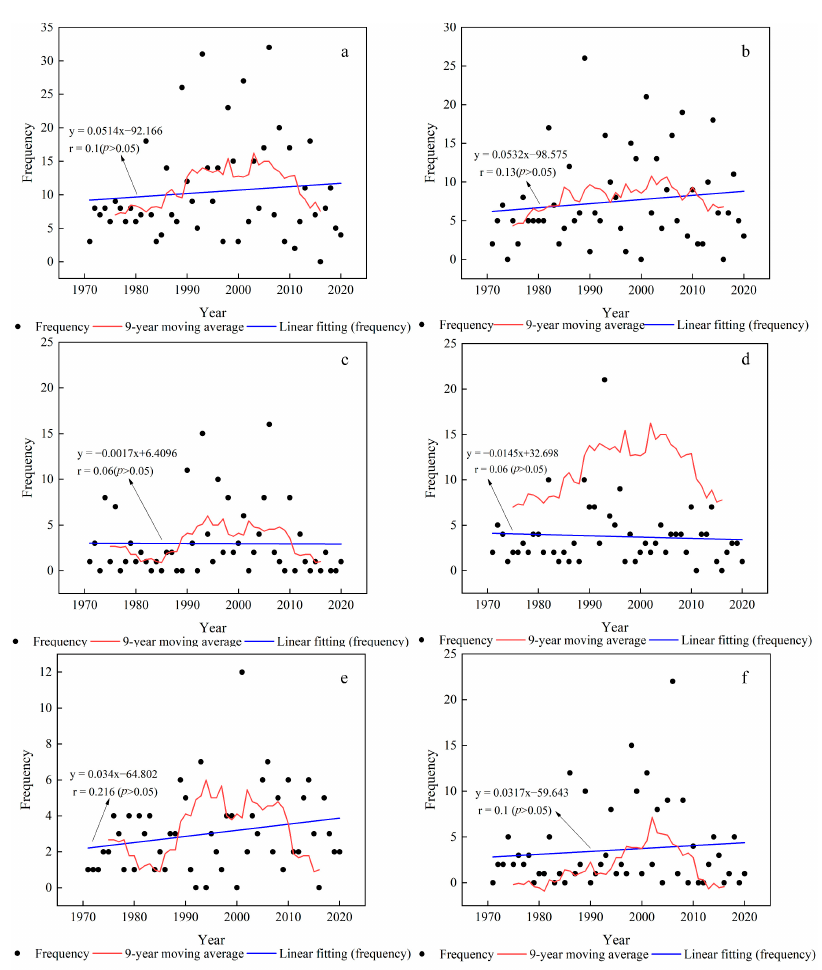
Figure 3. Temporal variations of the occurrence of spring frost in the entire Xinjiang ( a ), Northern Xinjiang ( b ), and Southern Xinjiang ( c ), as well as the trend of mild ( d ), moderate ( e ), and severe ( f ) spring frost.